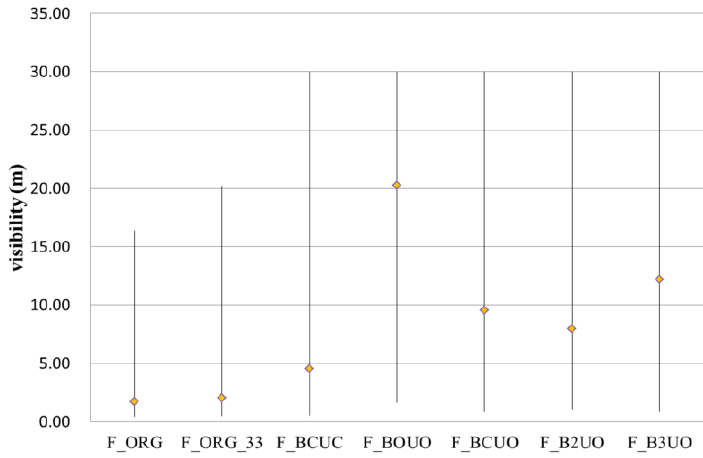
Figure 16. Visibility variations from 60 s to 240 s at Point D (at a height of 1.8 m).